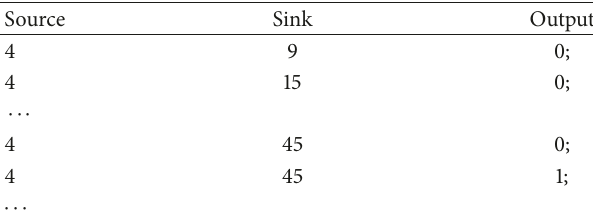
Table 2: Next generation of information connections between the nodes in the complex network.